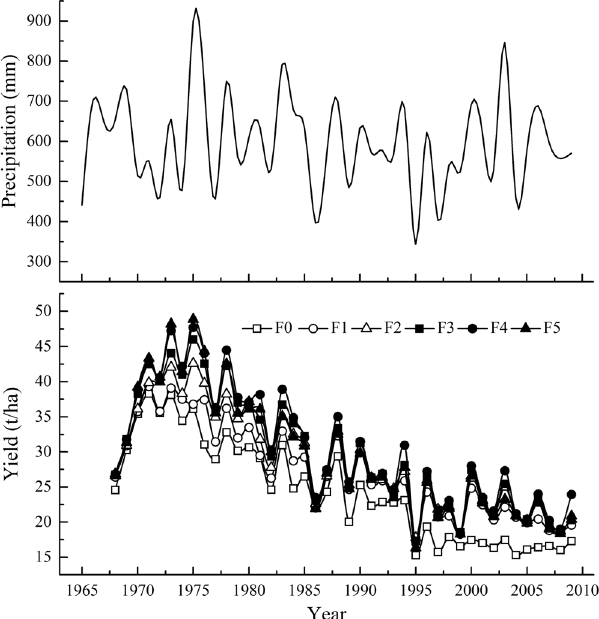
Figure 1. Simulated annual fruit yields under different fertilization treatments and precipitation in the apple orchards of